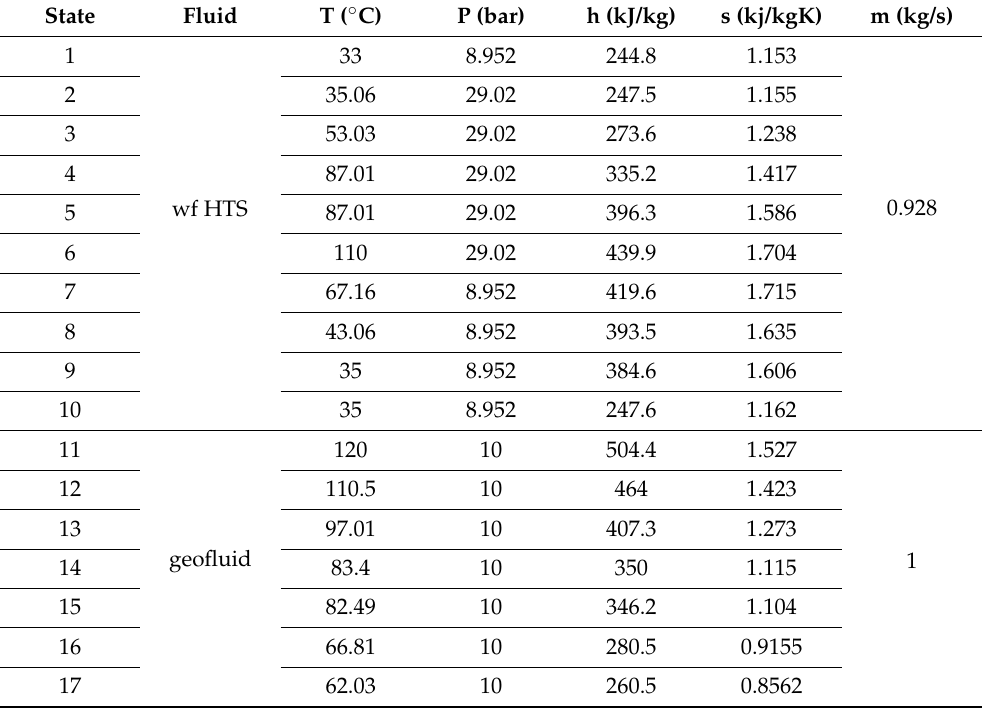
Table A8. Thermodynamic states of the working fluids, geothermal fluid (water), and cooling fluid (air) in characteristic points of the DS HTSIHE ORC configuration with R1234yf in HTS and LTS stages for a geothermal fluid temperature of 120 ◦